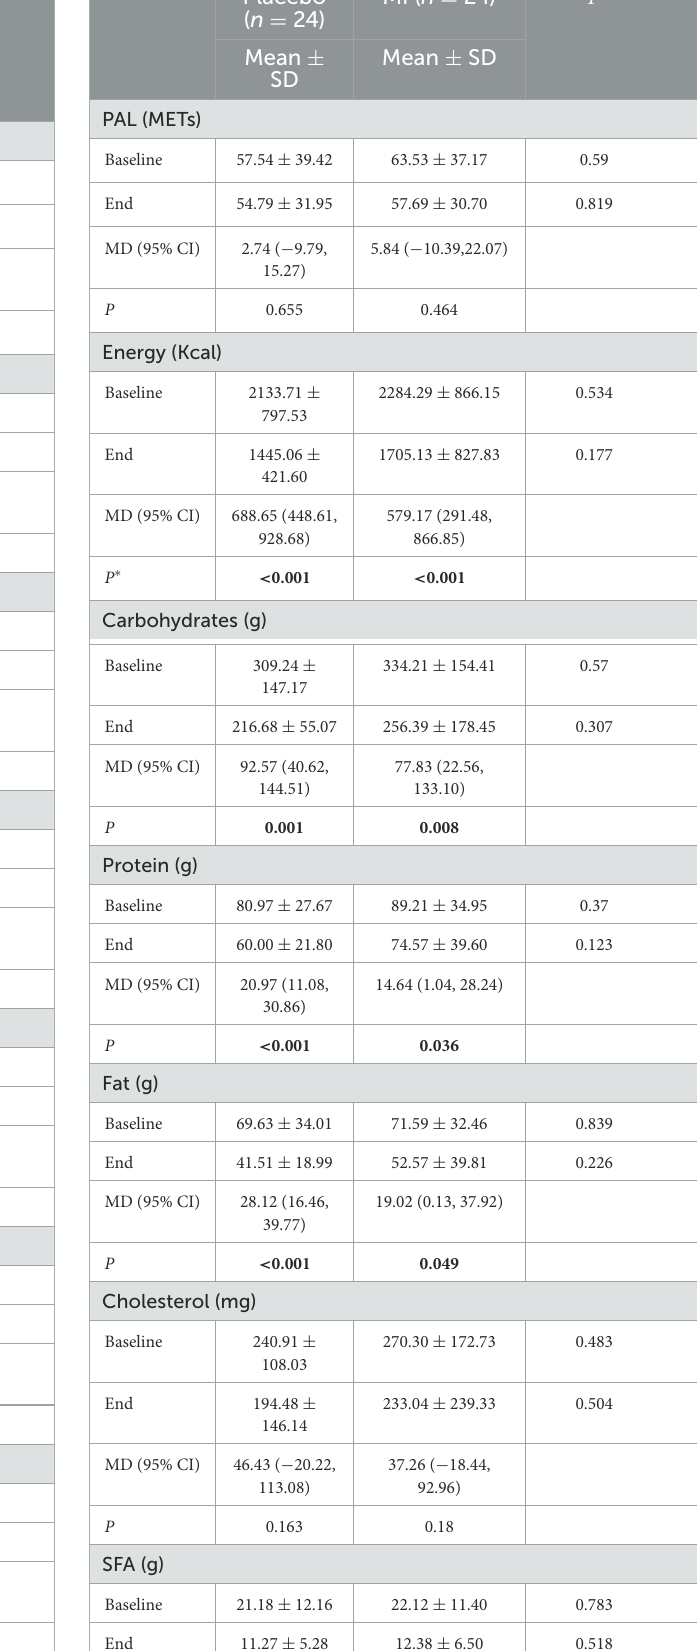
TABLE 2 Anthropometric, blood pressure, physical activity, and dietary intakes of the study participants throughout the